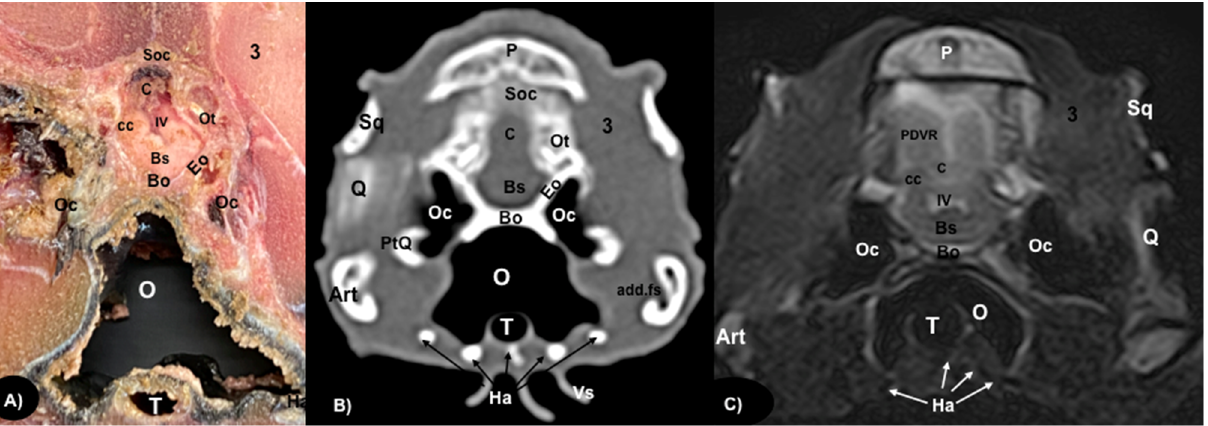
Figure 6. Transversal gross ‐ section ( A ), CT bone window ( B ) and MRI in T2W ( C ), images of the head of rhinoceros iguana at the level of the occipital region corresponding to line V in Figure 1. P: Parietal bone. Soc: Supraoccipital bone. Sq: Squamosal bone. 3: Musculus adductor mandibulae externus superficialis . C: Cerebellum. PDVR: Posterior Dorsal Ventricular Ridge. Bs: Brain stem. cc: Caudal colliculus. IV: Fourth ventricle. Ot: Otoccipital bone. Eo: Exoccipital bone. Bo: Basioccipital bone.